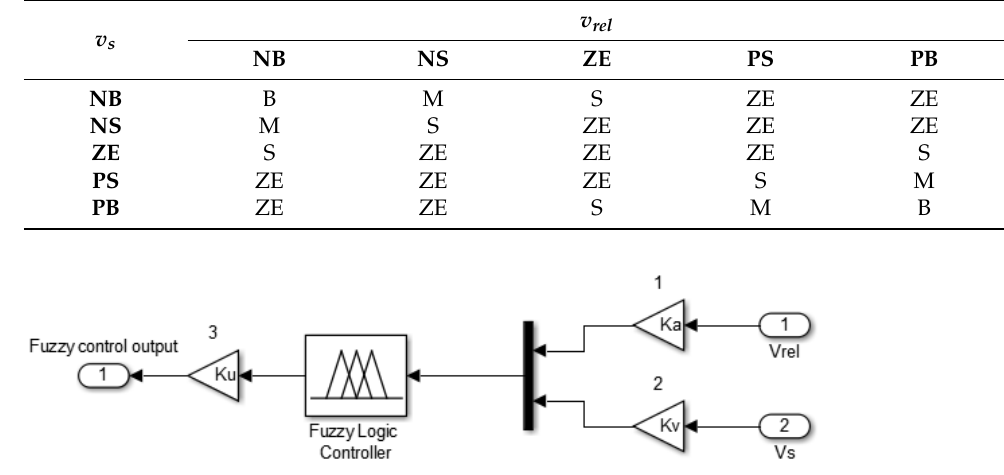
Table 3. Fuzzy control rule table.